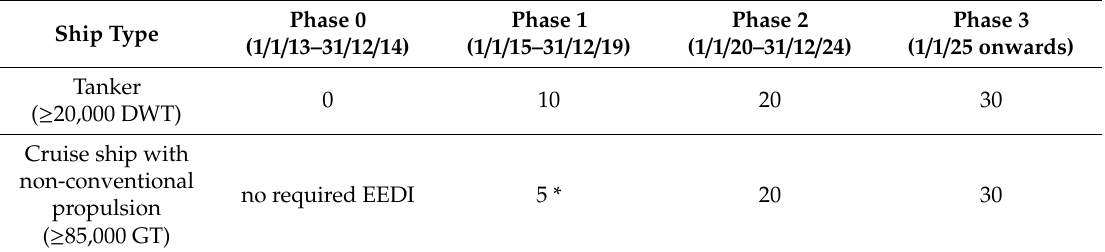
Table 7. EEDI reduction factor